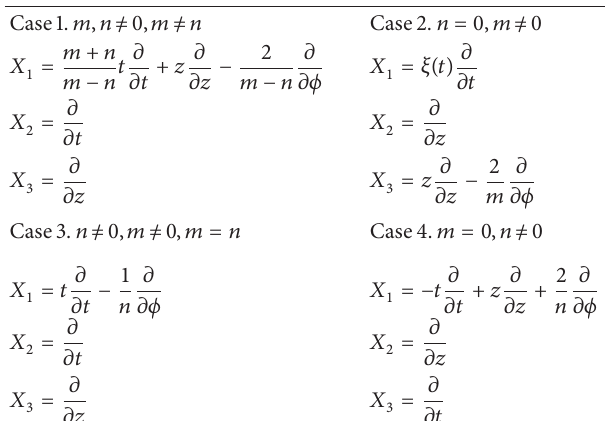
Table 4: Lie point symmetries of the partial differential equation